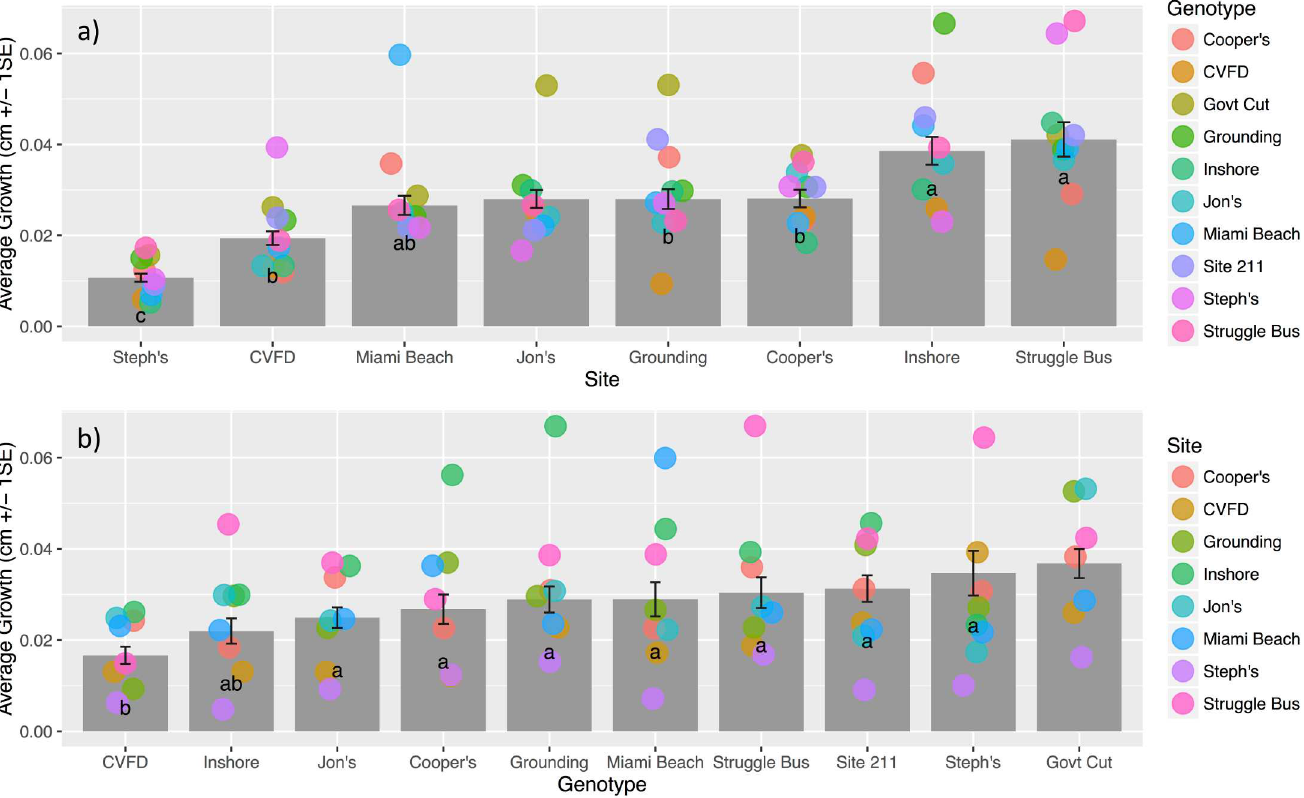
Fig 2. Growth of pooled corals by treatment. (a) Average LE (cm/day +/- 1 S.E.) at each site with all genotypes pooled.Due to logisticalconstraints, the fully crossed design did not includethe site Jon’s Reef, which is includedfor representation but was not includedin 2-way ANOVA analysis. Letters represent significantdifference levels in log transformed data (Tukey’s HSD, p < 0.05), but untransformed data is presented here. Jittered points represent the growth of each genotypewithin that site and are color codedby genotype. (b) Average LE (cm/day +/- 1 S.E.) of each genotype, pooledacross all sites. Due to logisticalconstraints, the fully crossed design did not includethe genotypeGovernment Cut, which is includedfor representation but was not includedin 2-way ANOVA analysis. Letters represent significantdifference levels in log transformed data (Tukey’s HSD, p < 0.05),but untransformed data is presented. Jittered points represent the growth at each site for that genotypeand are color codedby site.